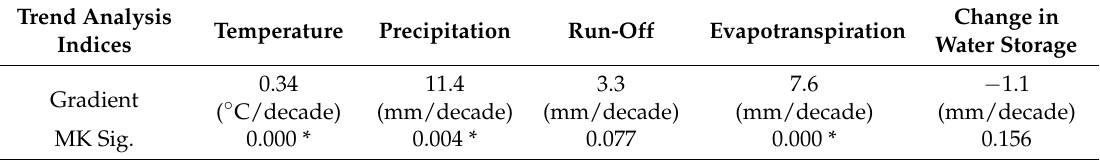
Table 2. Trend analysis for investigated hydro-climatic variables in the SRYR. Trend